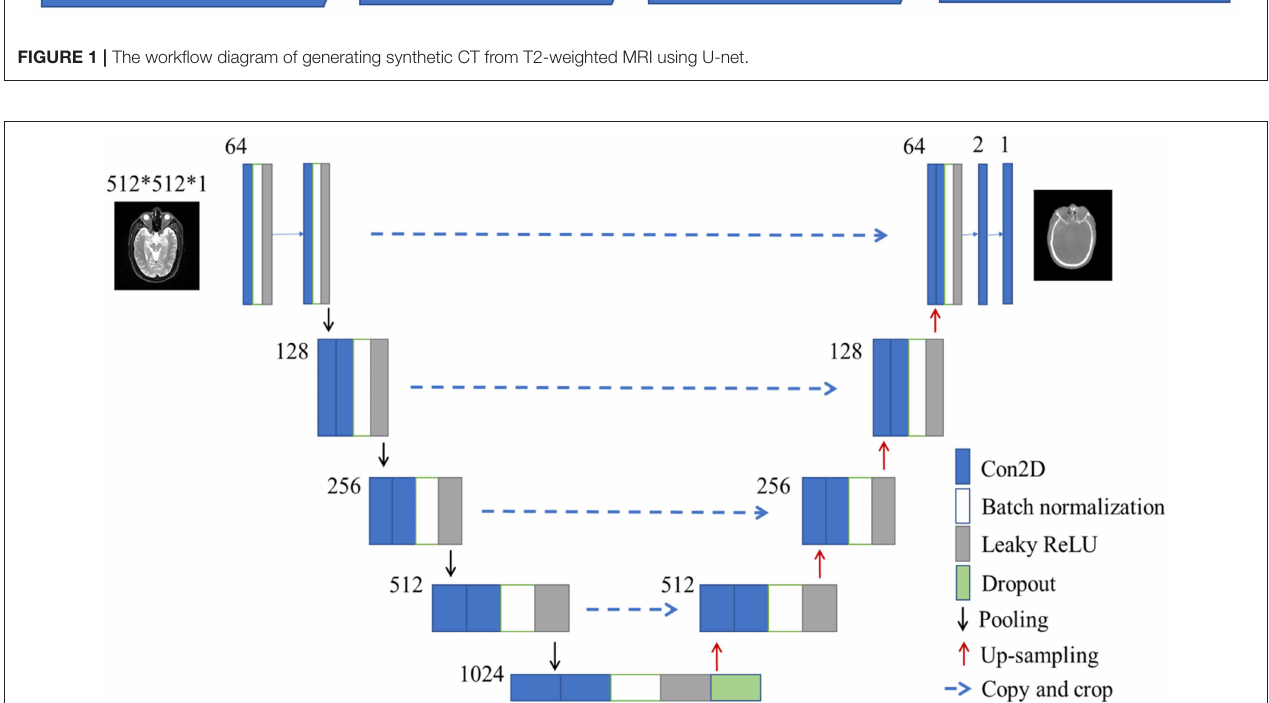
FIGURE 2 | The architecture of U-net used in this study. The size of input images is 512*512*1 pixels. Blue box is multi-channel feature map, and the number on the top-left of the box is channel number. White box is batch normalization. Gray box is leaky ReLU. Green box is dropout module.